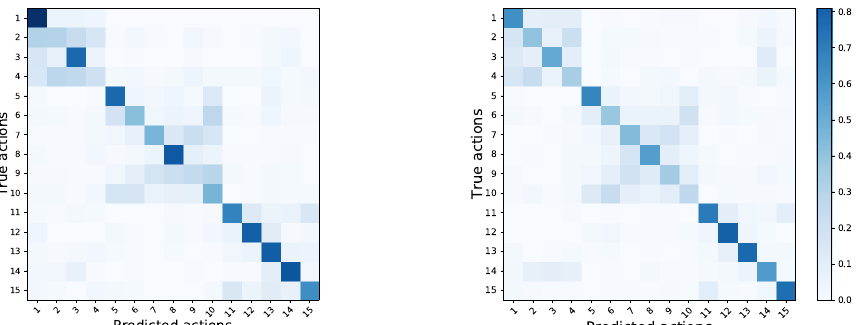
Figure 7. Confusion matrices for: ( left )—DM3DCNN with fine tuning; ( right )—DGNN with pretraining on the NTU RGB+D